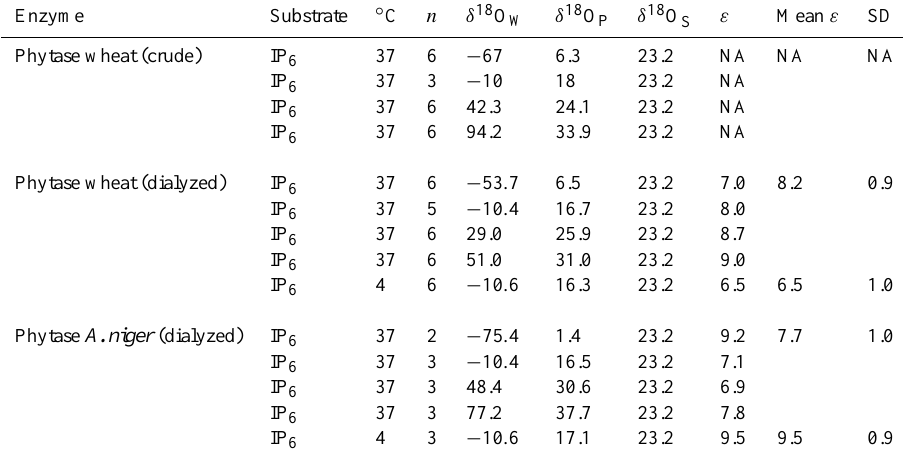
Table 2. δ 18 O values (‰) of water ( δ 18 O W ), released phosphate ( δ 18 O P ) and phosphate in organic P compound ( δ 18 O S ) as well as isotopic fractionation ( ε ), which was calculated according to Eqs. (6) and (7) with an assumed δ 18 O CON value of 15‰. Results are from experiments with IP 6 as a substrate and with phytases from wheat and Aspergillus niger